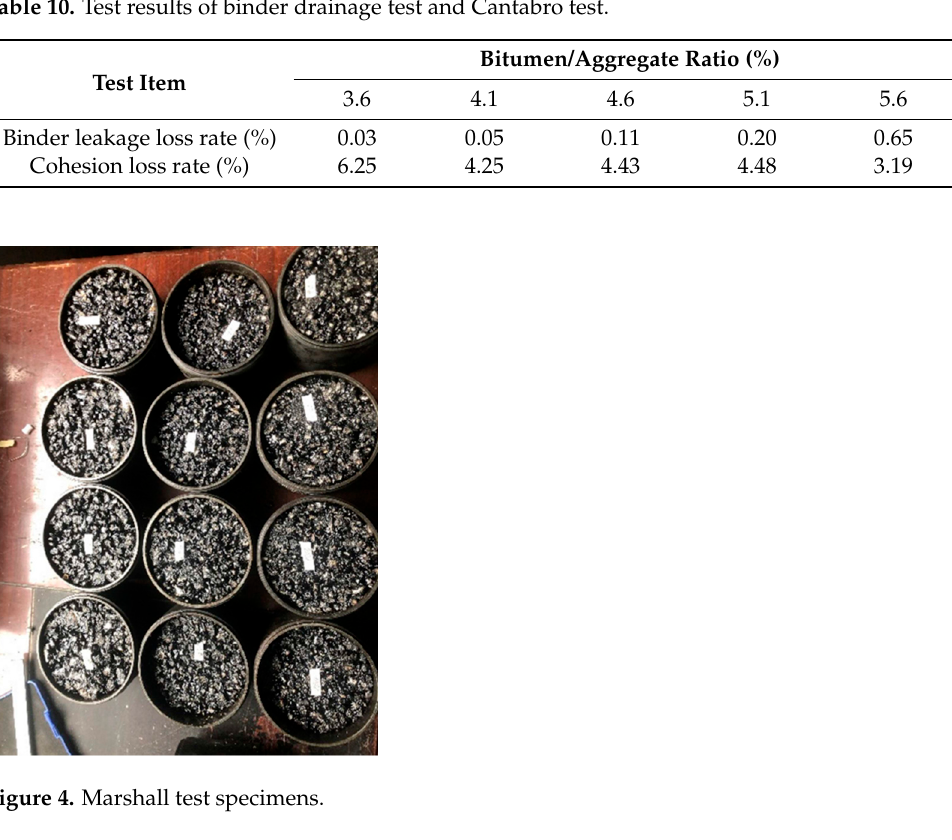
Figure 5. Demoulding process of Marshall test specimens.